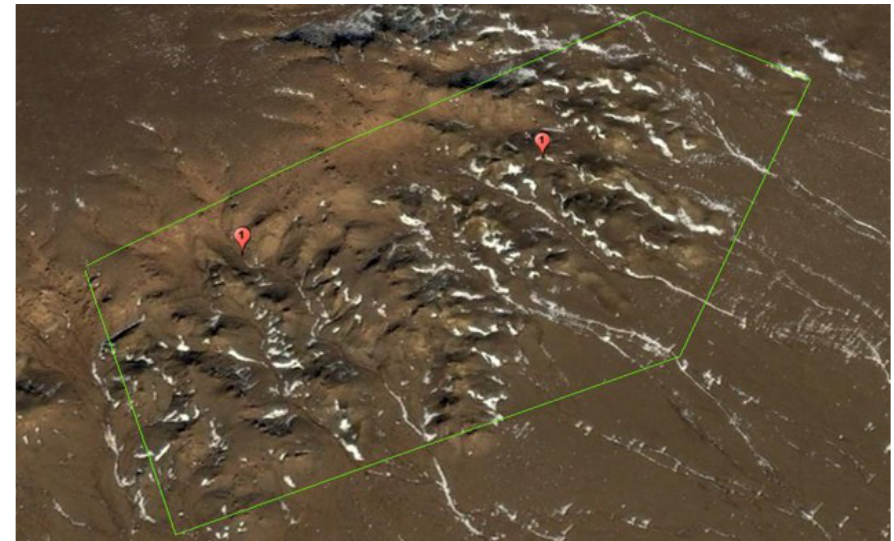
Fig. 12. Location, where some fossilized fragments of dinosaur are revealed